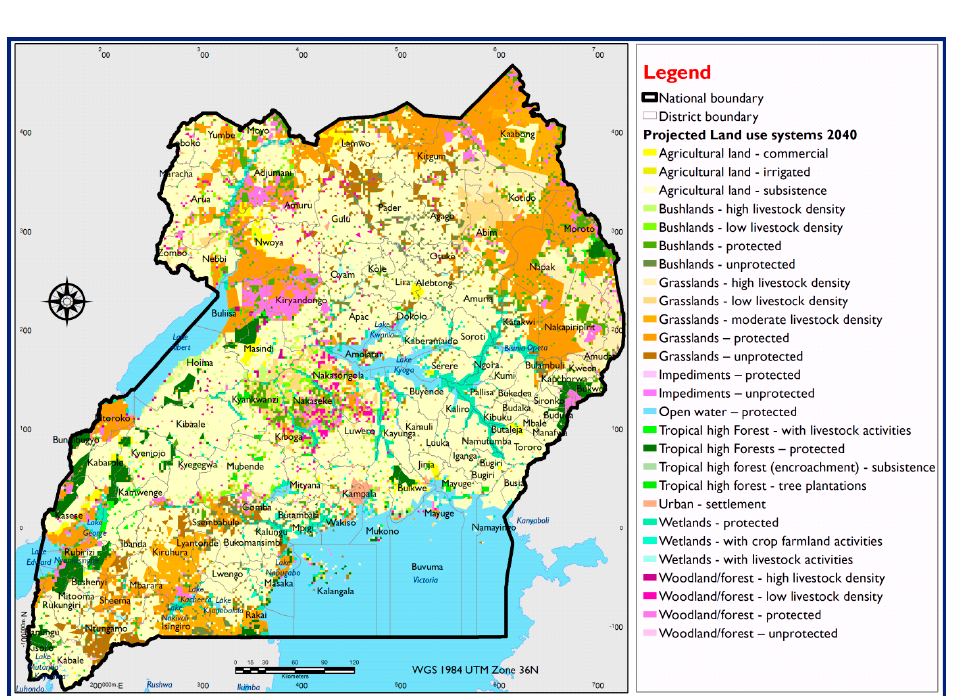
Figure 6. Projected land use systems of Uganda for the year 2040.